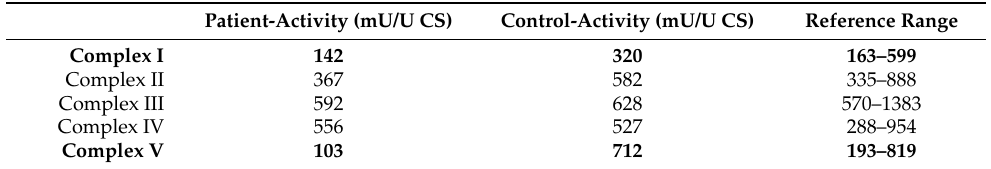
Bold font indicates complex for which reduced activity was observed. Abbreviations: CS, citrate Figure 3. Seahorse XF96 respirometry analysis. ( A ) Oxygen consumption rate measured before and after the addition of inhibitors. These modulators are electron transport chain inhibitors (oligomycin, FCCP, and a mixture of rotenone and antimycin A), which are serially injected to measure ATP production, Max Resp, Non-Mito Resp, proton leak, SRC, and Basal Resp. ( B ) The basal energy metabolism of each cell line was assessed by determining OCR:ECAR ratios following sequential injection of the inhibitors. Abbreviations: Basal Resp, basal respiration; ECAR, extracellular acidification rate; FCCP, carbonyl cyanide-p-trifluoromethoxyphenylhydrazone; Max Resp, maximal respiration; Non-Mito Resp, non-